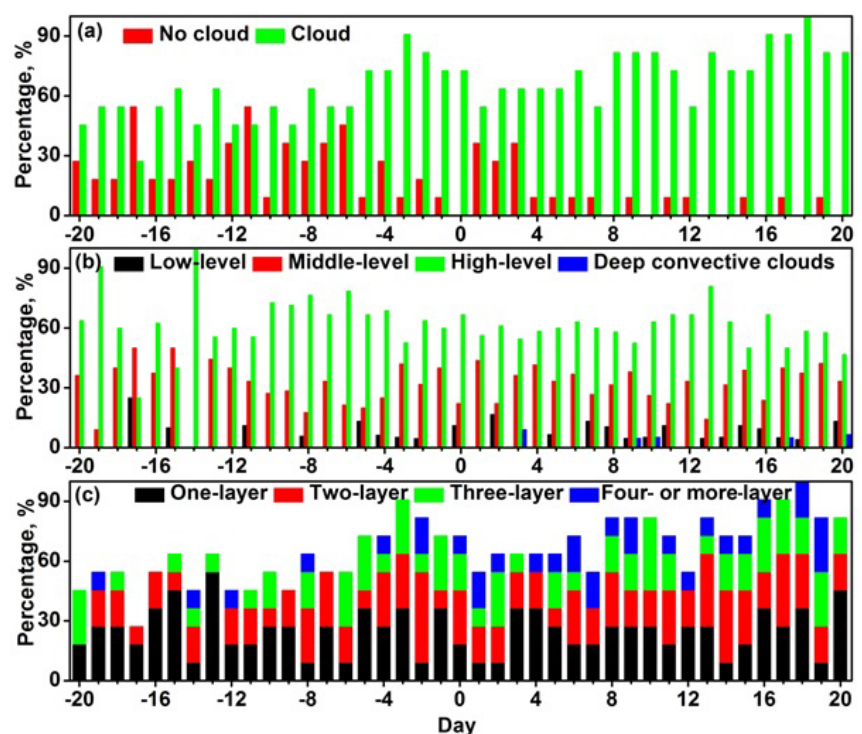
Figure 12. Composite (2006–2016) percentage of occurrence of (a) clear and cloud conditions, (b) low-level, middle-level, high-level, and deep convective cloud, and (c) one-, two-, three-, and four- or more-layer clouds observed with respect to the date of monsoon arrival over the Gadanki location. Zero on the x axis indicates the date of monsoon arrival over the Gadanki location.